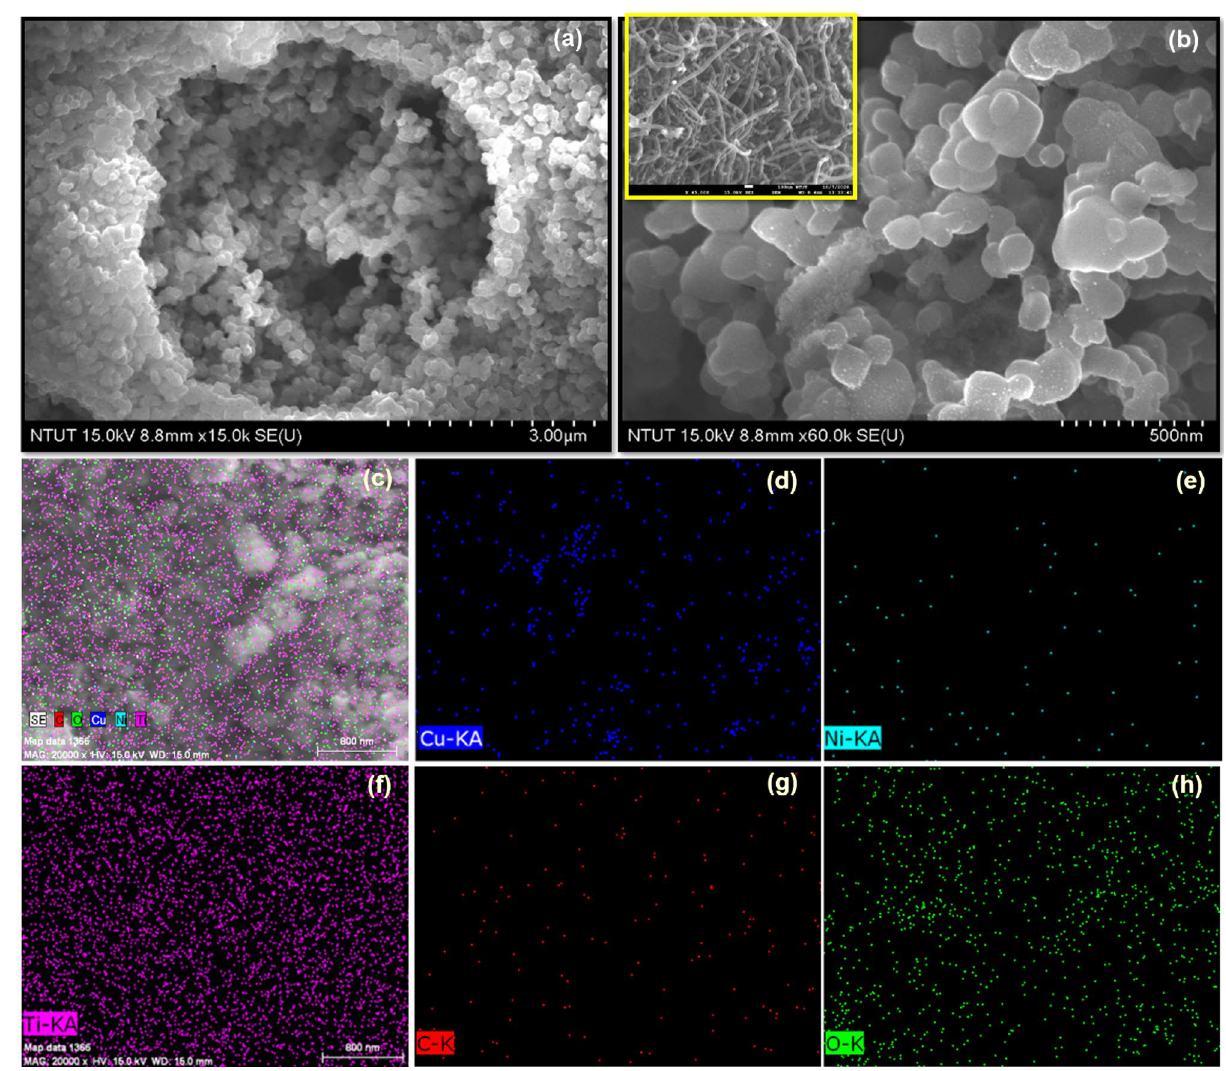
Figure 3. ( a , & b ) FESEM images of Cu/Ni/TiO 2 /MWCNTs nanocomposites, and ( c ) the combined elemental mapping of